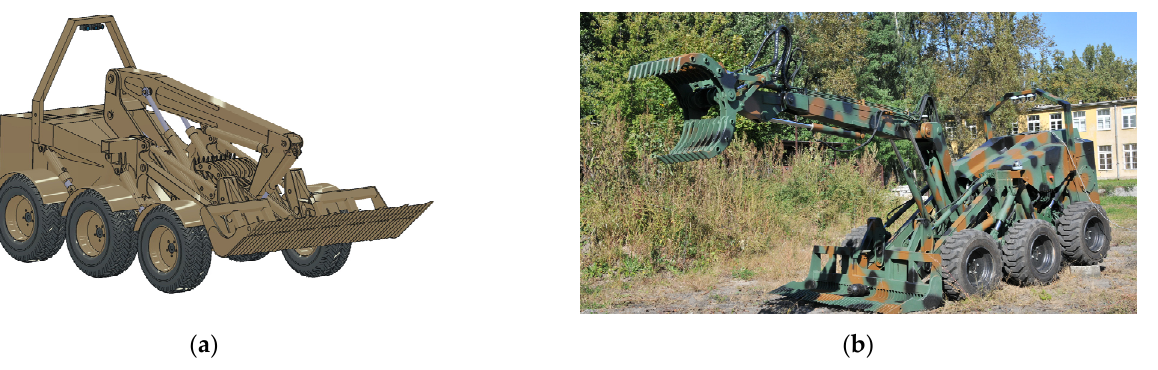
Figure 1. View of a 3D CAD model of the robot ( a ) and 6 × 6 robot ( b ) [14].